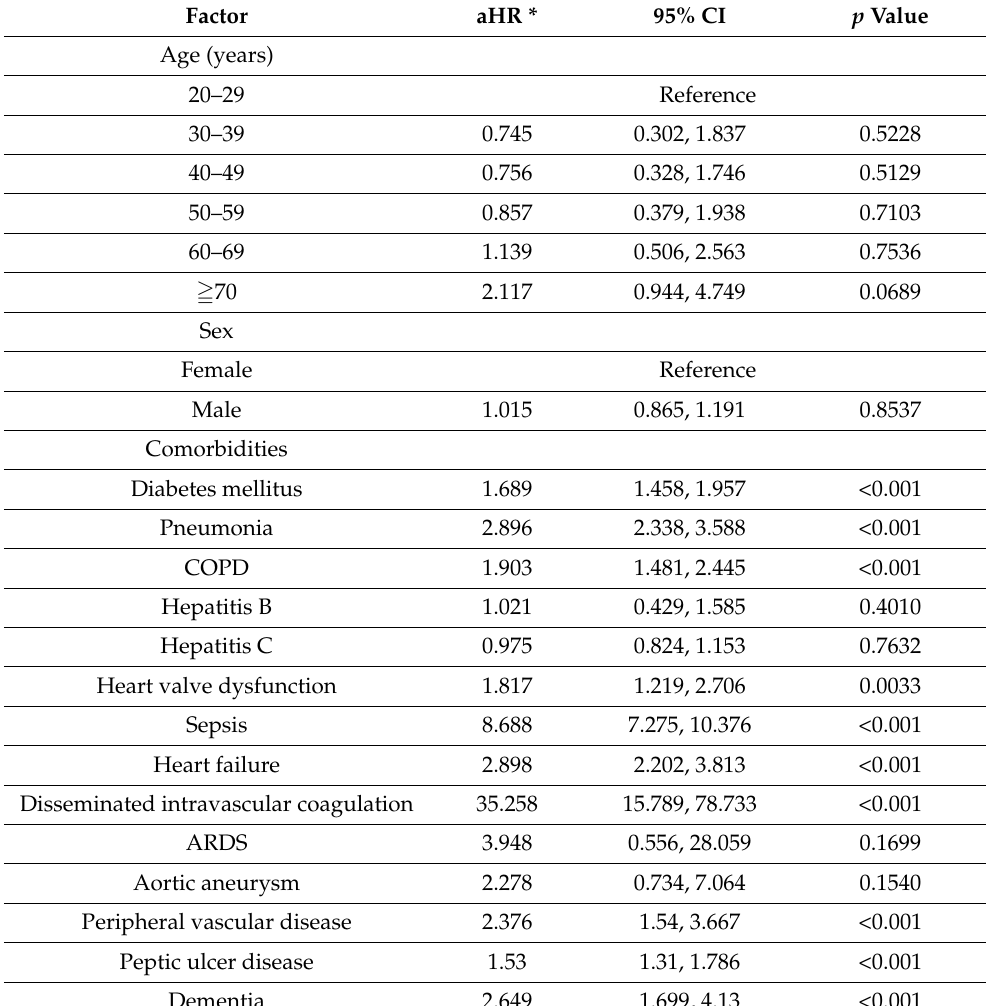
Table 2. All-Cause 90-Day Mortality Risk Assessment Using a Multivariate Cox Proportional Hazards Model in Patients with Hepatocellular Carcinoma Undergoing Major Hepatectomy. aHR * 95%